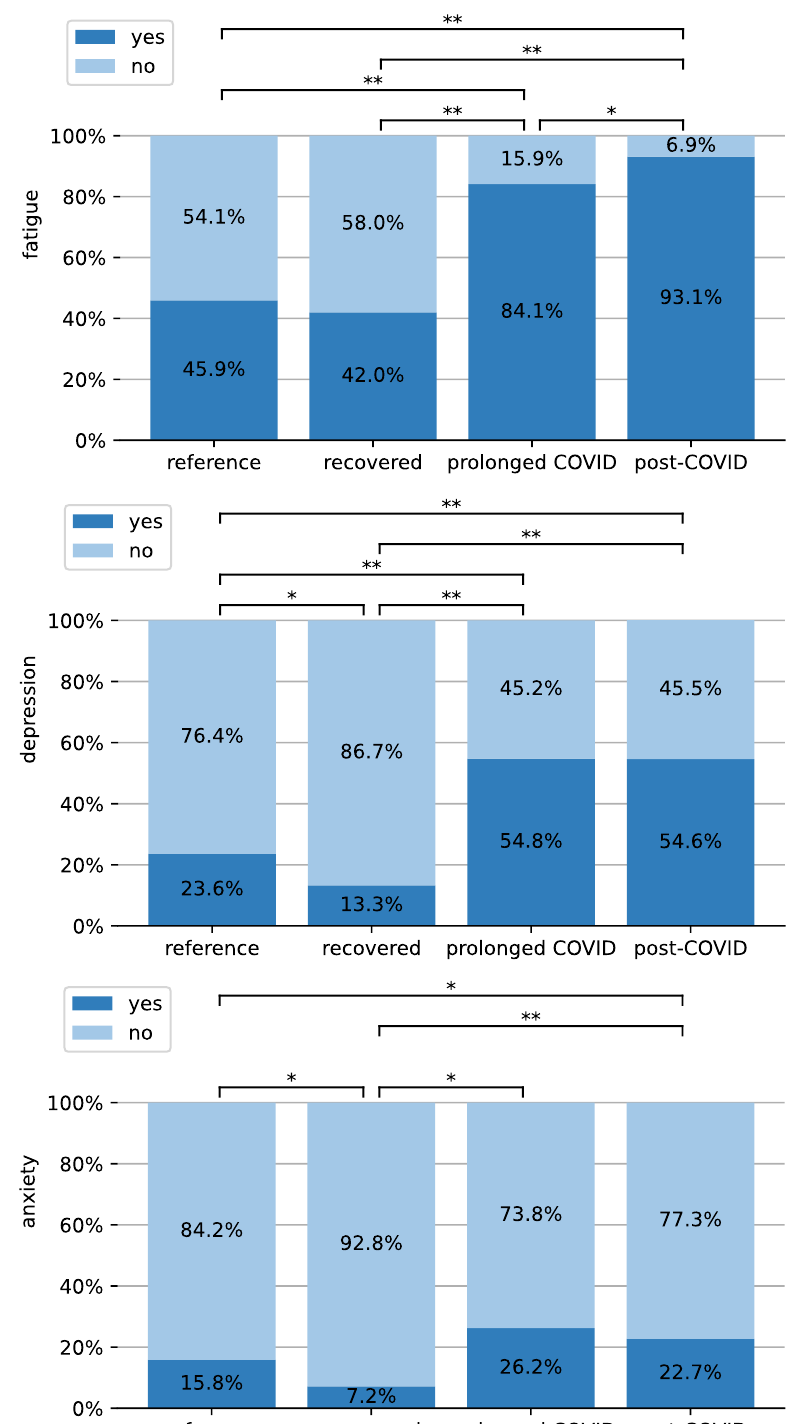
22), anxiety disorders (GAD-7 10) and depression (PHQ-9 ≥ ≥ 0.05, ** : p 0.001. ≤ ≤